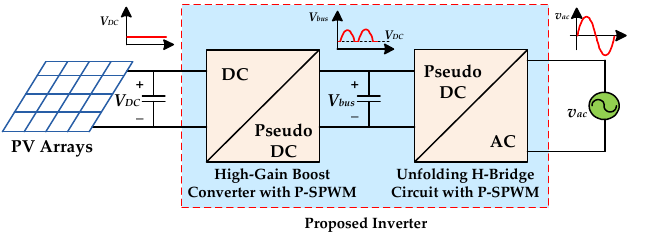
Figure 3. The grid-connected PV power system with the proposed high-efficiency inverter.